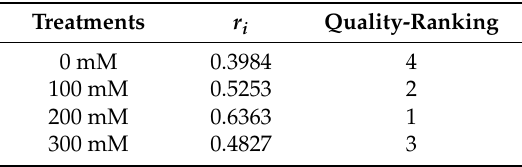
Table 2. Quality sequencing of the tested samples affected by